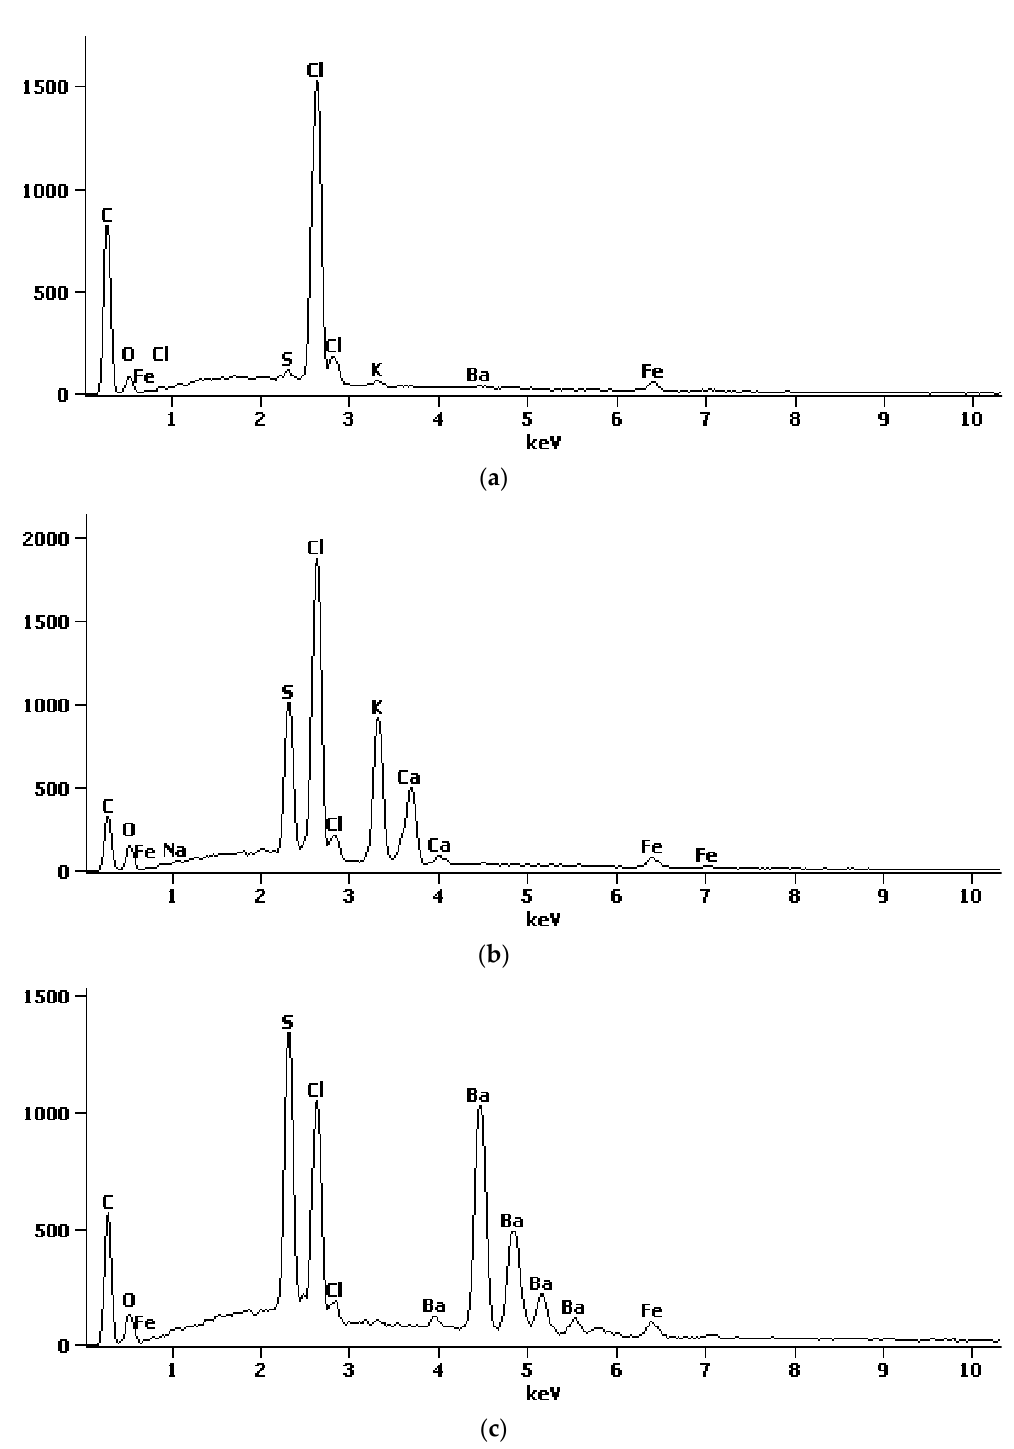
Figure 10. EDS spectrum energy [keV} vs. intensity [cps/eV] in areas of bacterial colony development. ( a ) Point 1 in Figure 9, ( b ) point 2 in Figure 9, ( c ) point 3 (and 4,5,6, respectively) in Figure 9.